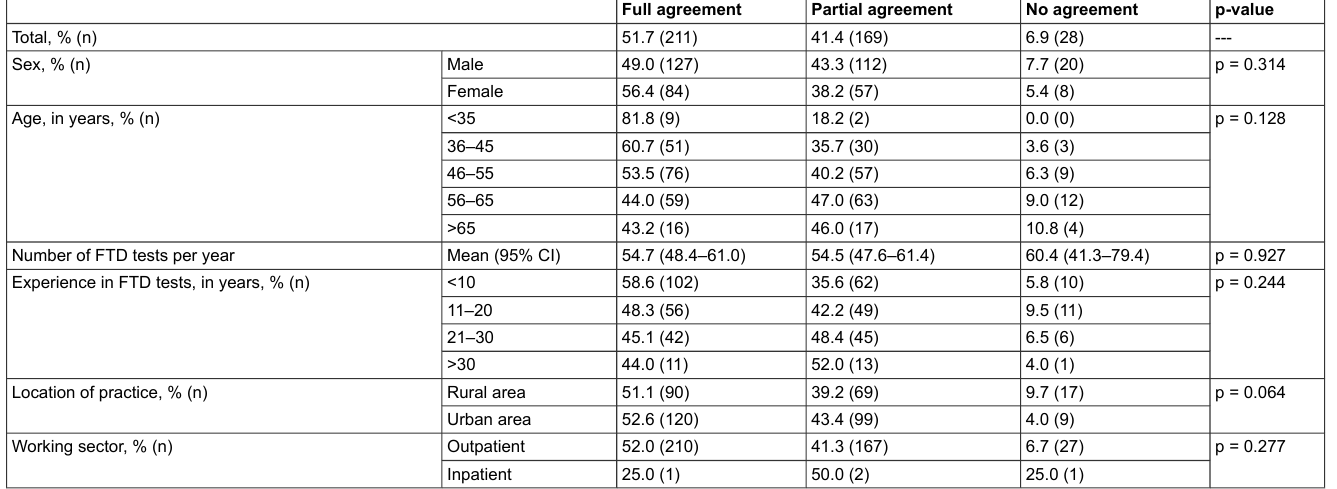
Table 3: Competence in assessing driving ability after attending the level 1 course.